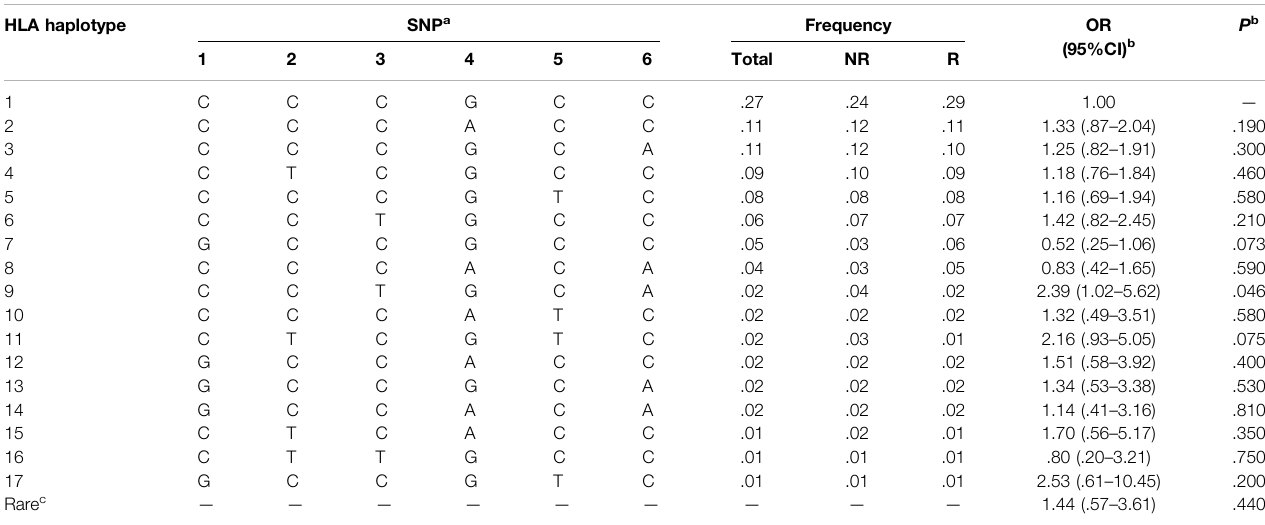
TABLE 7 | Haplotype